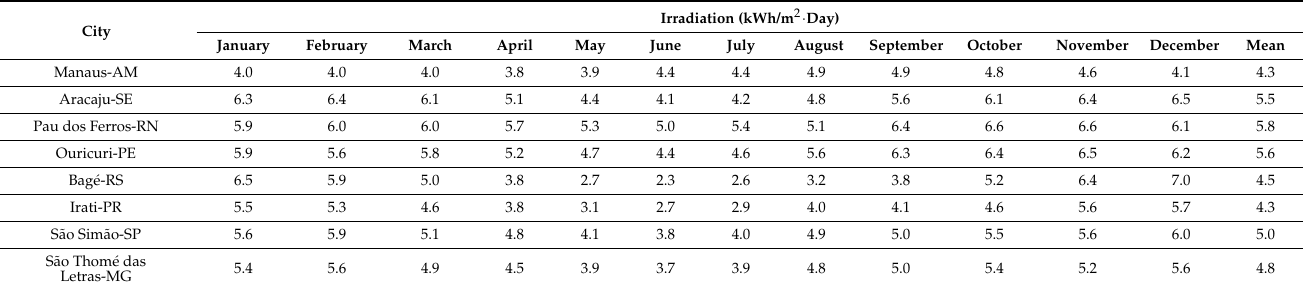
Table 2. Values of monthly mean solar irradiation (kWh/m 2 .day) in the analyzed cities. City